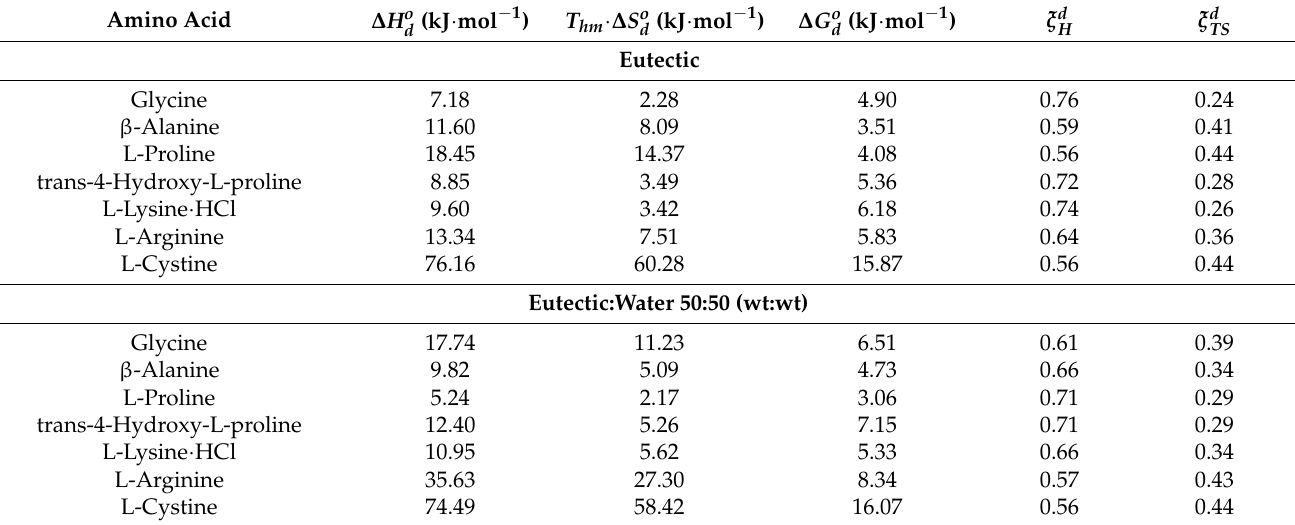
Table 5. Apparent properties of dissolution.